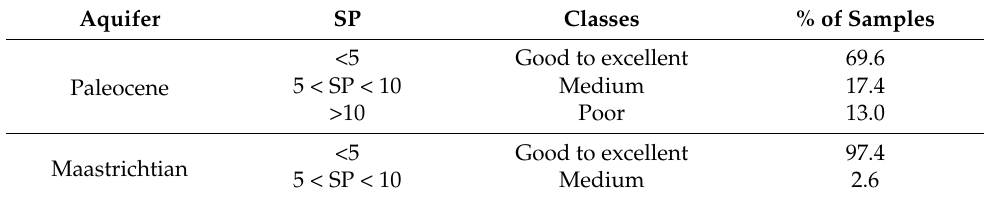
Table 7. Classification of water according to their salinity potential